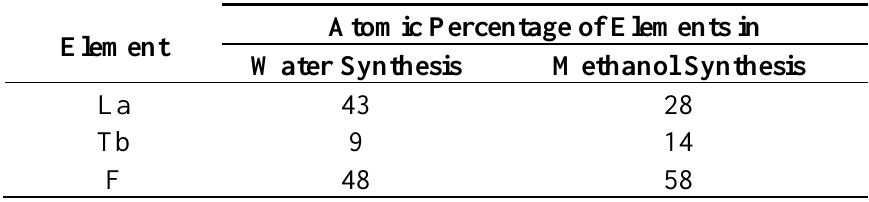
Figure 3. Absorption spectra of acetylsalicylic acid (ASA) (blue), ASA (red) ligand, Tb(NO ) ·6H O (green) and Tb 3+ :LaF 3 3 2